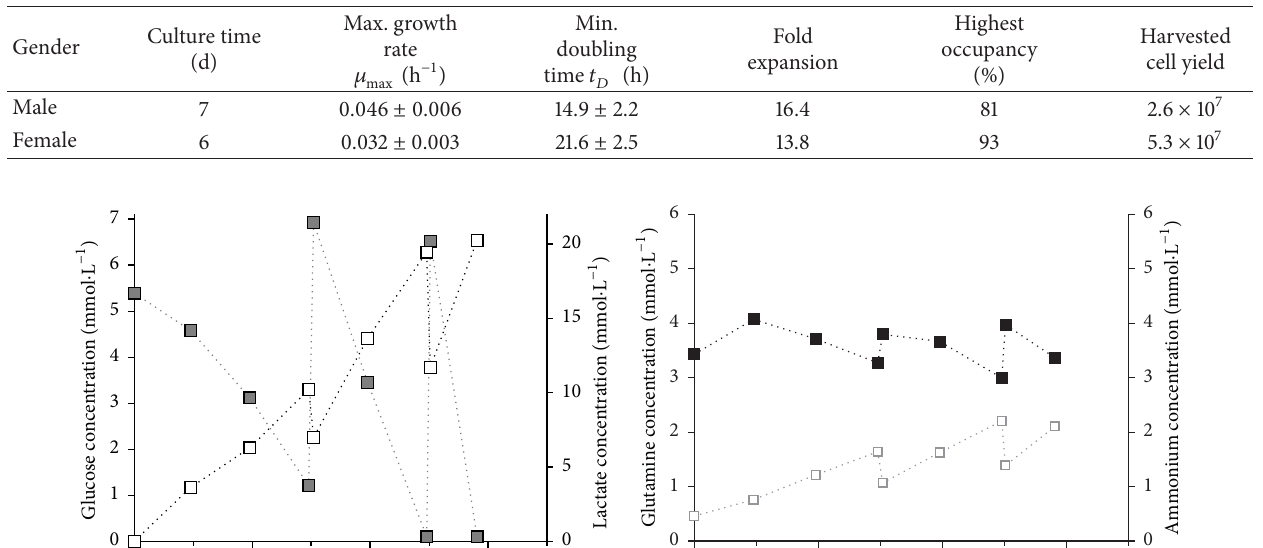
Table 3: Growth characteristics for hUC MSCs on Plastic Plus microcarriers in spinner flasks with 100mL DMEM LG culture medium at a seeding density of 8000 cells ⋅ cm −2 .